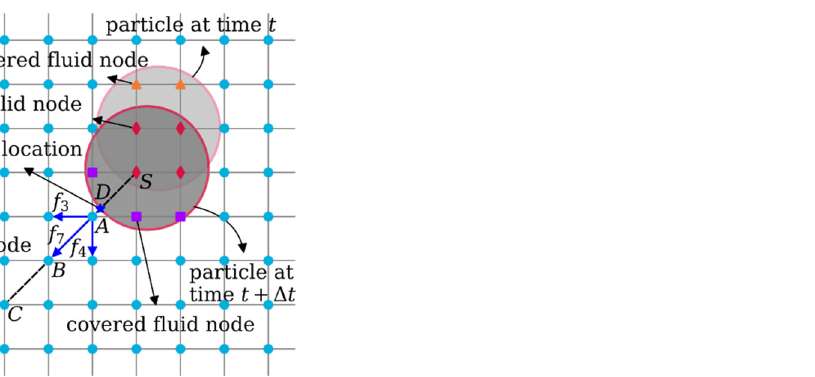
Figure 2. Improved bounce-back scheme boundary conditions. Lighter gray circle represents the location of particle at time t and darker gray circle at time t + ∆ t, which result in two orange triangles uncover to fluid node, three purple squares cover to solid node and four red thin diamonds remain solid node. The other sky-blue circles denote the fluid nodes. The distribution function f 7 can be determined by the information of node S, D, A, B, C .